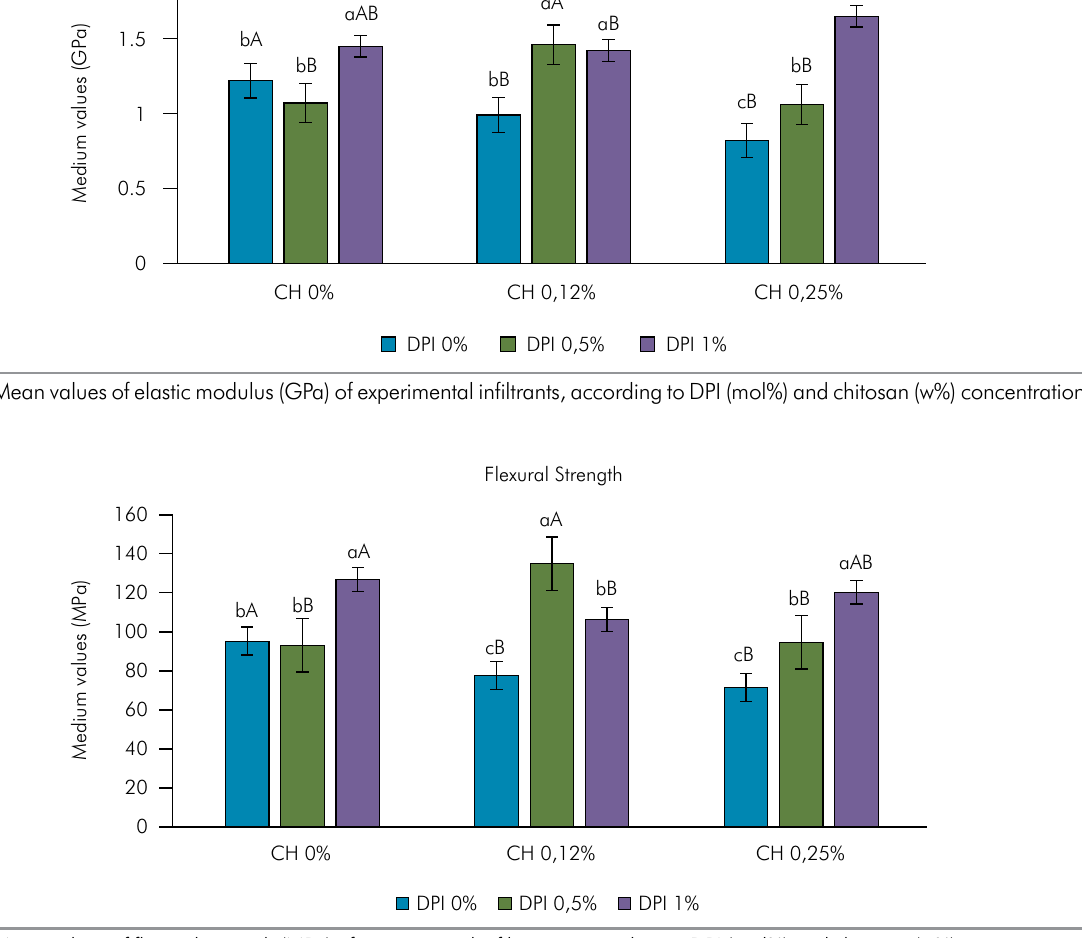
Figure 3. Mean values of flexural strength (MPa) of experimental infiltrants, according to DPI (mol%) and chitosan (w%)